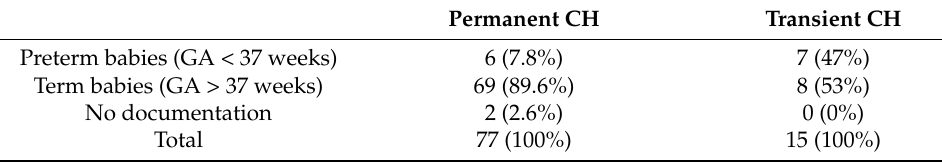
Table 6. Distribution of term and preterm babies with CH. [n (%)].